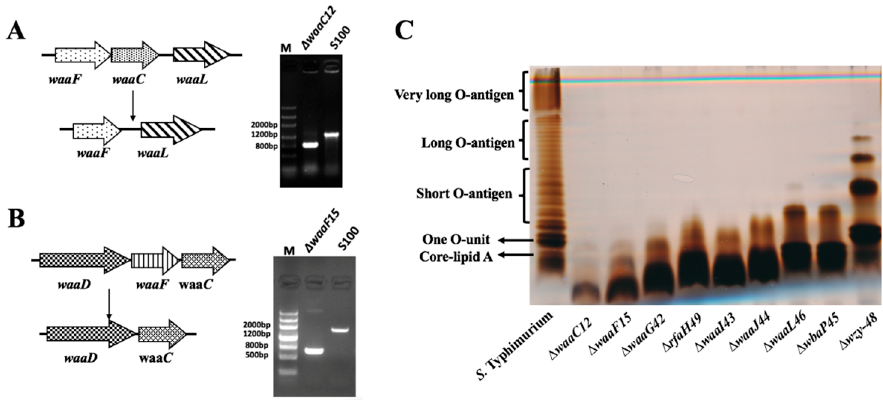
Figure 2. Mutant construction and LPS profiles. ( A ) Map of the deletion mutation of ∆ waaC12 ( left ), and PCR verification of the ∆ waaC12 ( right ); ( B ) map of the deletion mutation of waaF15 ( left ) and PCR verification of the ∆ waaC12 ( right ); and ( C ) LPS patterns of the mutants and the parent strain. LPS was visualized by silver straining on polyacrylamide gel electrophoresis (PAGE) gels. The expected location of O -antigen components and the core is shown on the left, and the O -unit is a repeating unit of the O -antigen.